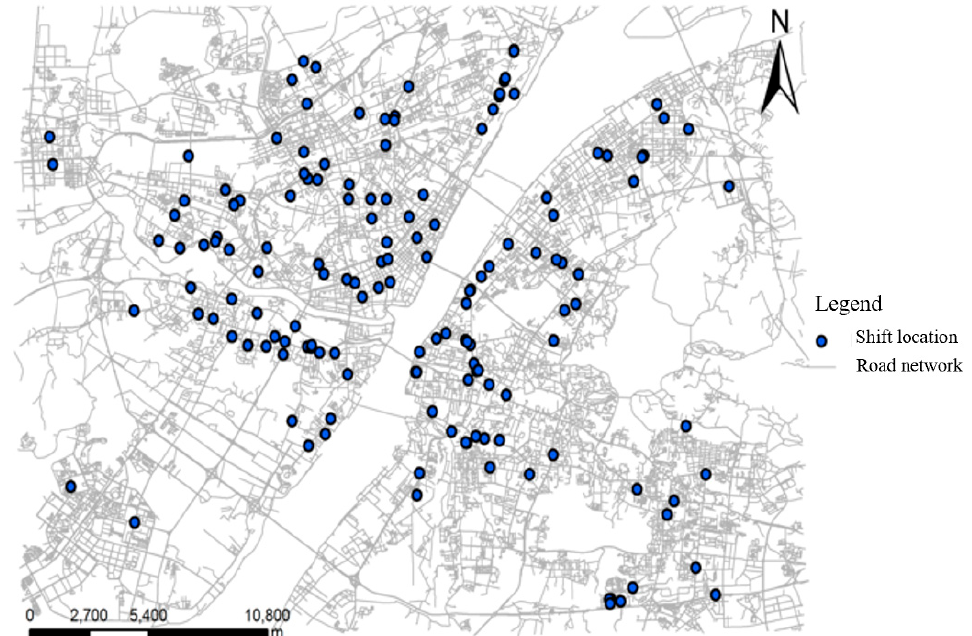
Figure 12. Spatial distribution of serious violations of taxi-driver shift activities.